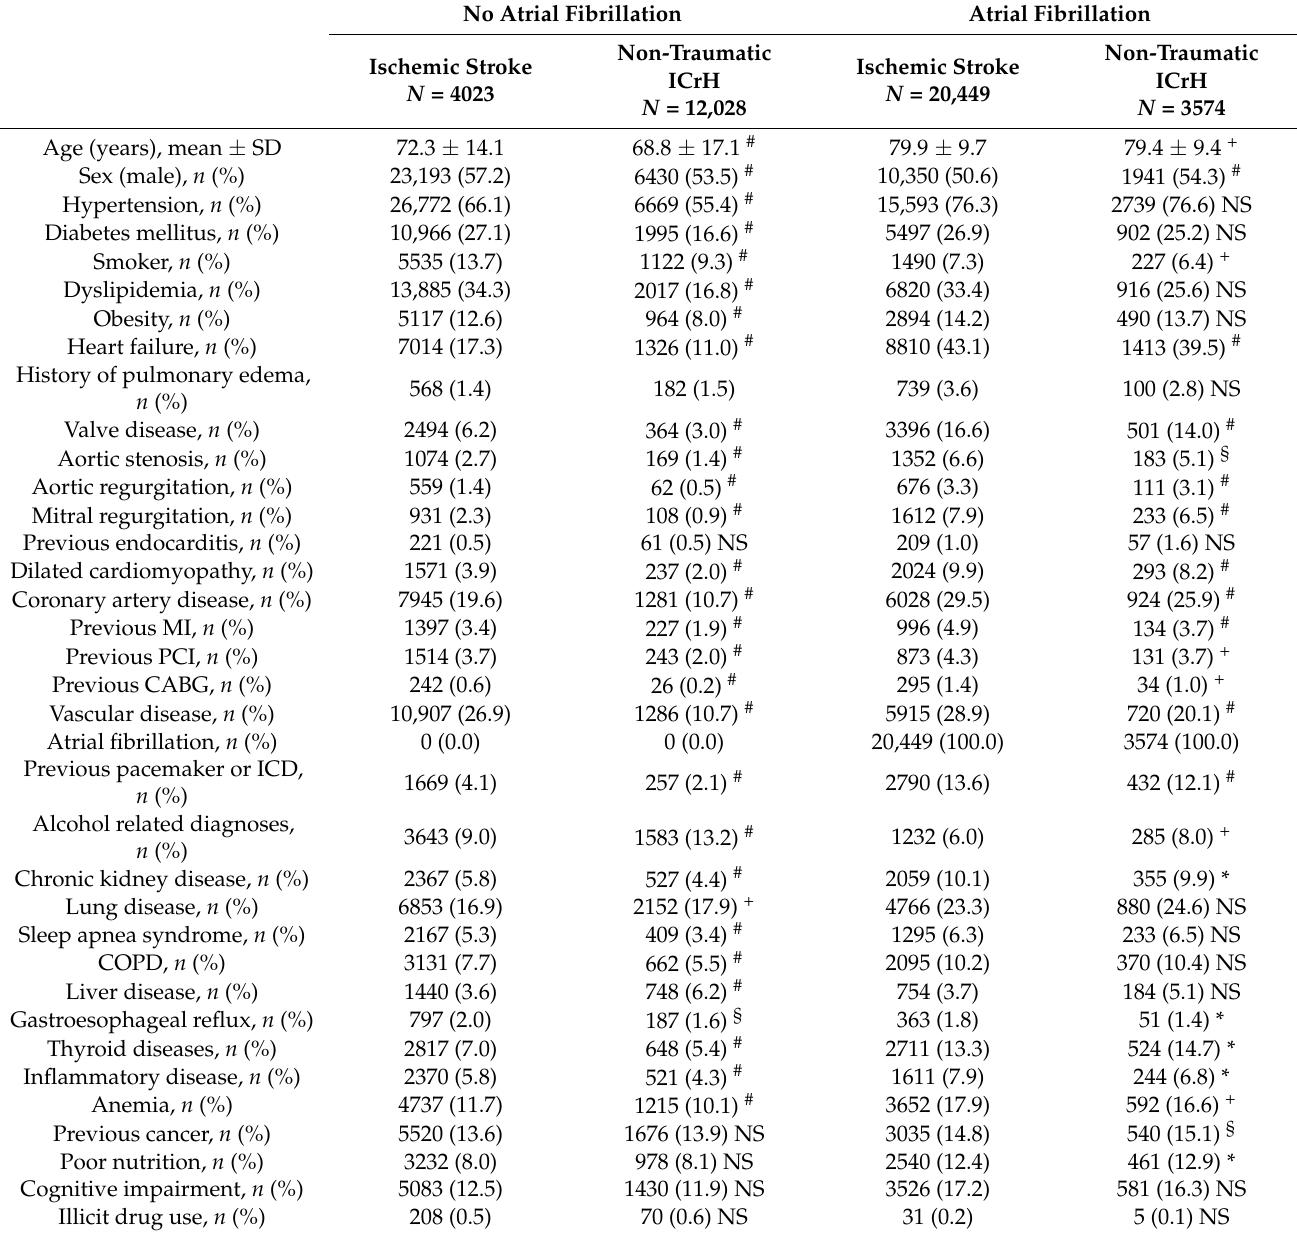
Table 1. Baseline characteristics of unmatched patients with history and no history of atrial fibrillation at baseline in ischemic stroke and non-traumatic intracranial hemorrhage survivors.